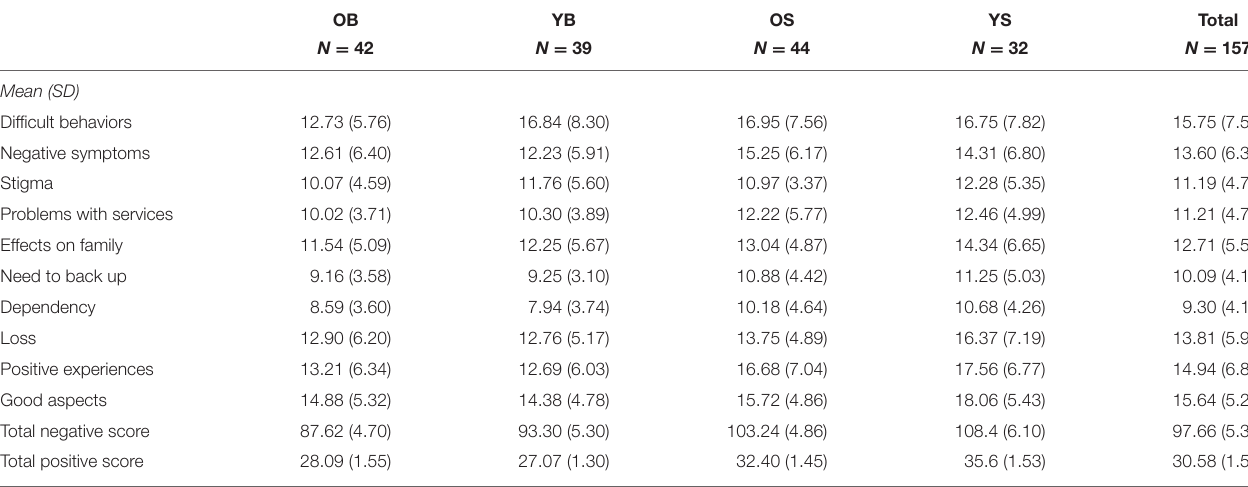
TABLE 3 | The experience of caregiving, sibling gender, and birth order.